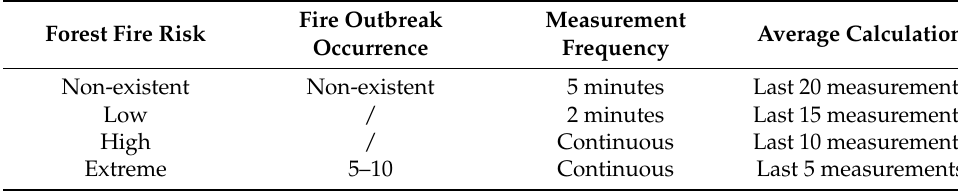
Table 4. Measurement frequency and average calculation of fire risk factors.